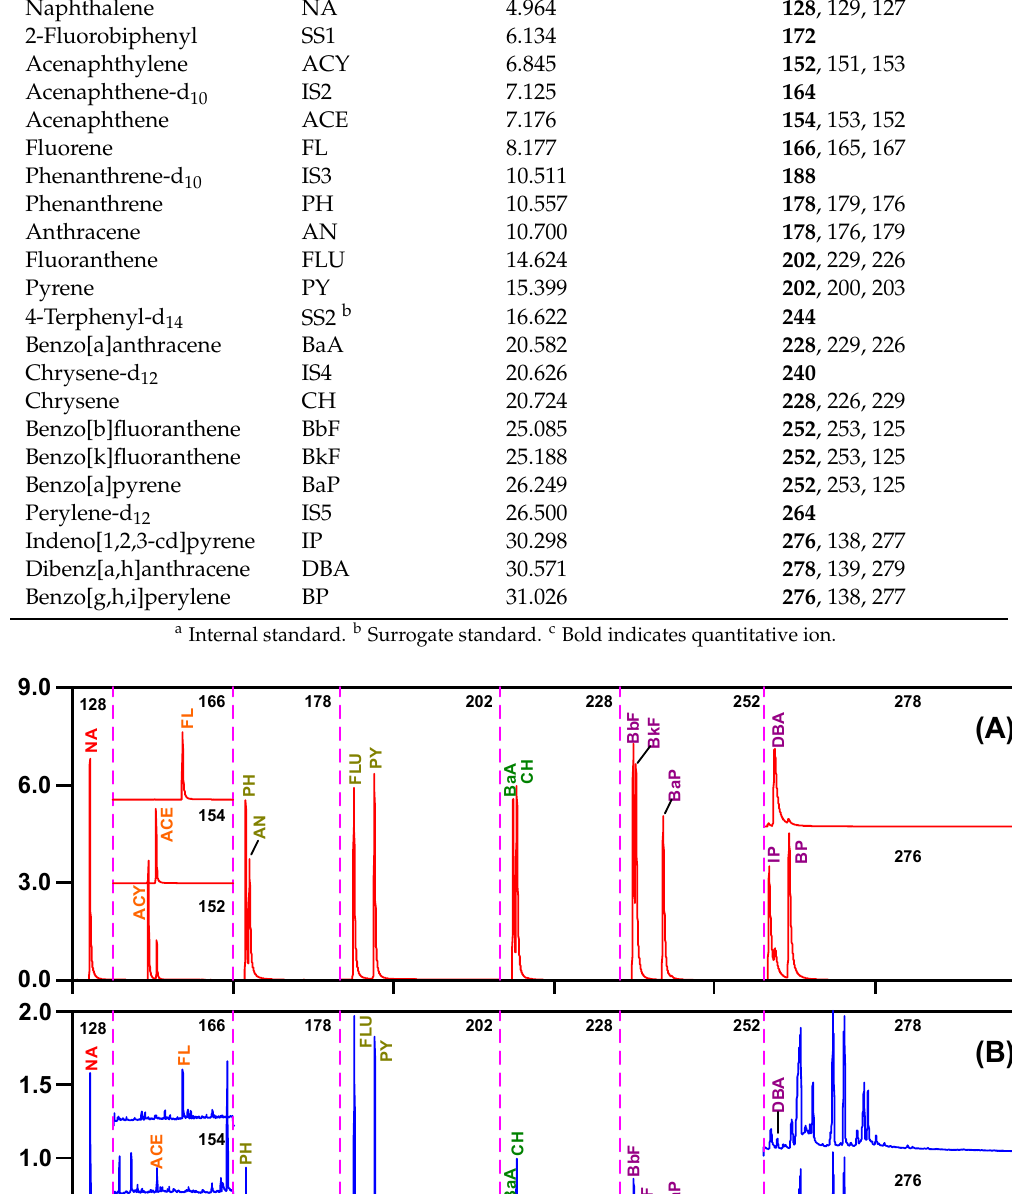
Table 2. Selected ion monitoring of each PAHs in GC-MS system.